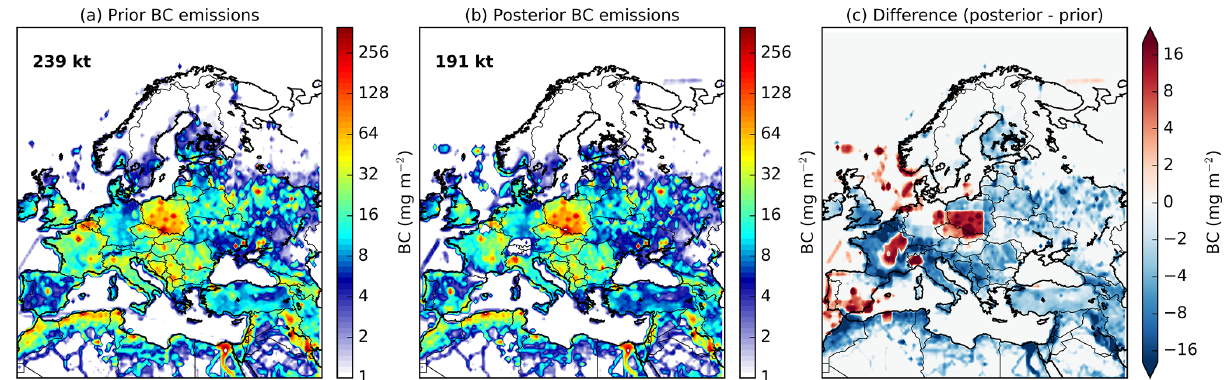
Figure 4. (a) Prior emissions of BC from ECLIPSEv6, (b) optimized (posterior) BC emissions after processing the ACTRIS data into the inversion algorithm and (c) difference between posterior and prior emissions. All the results correspond to the inversion yielding the best results (Table 2 and Fig.